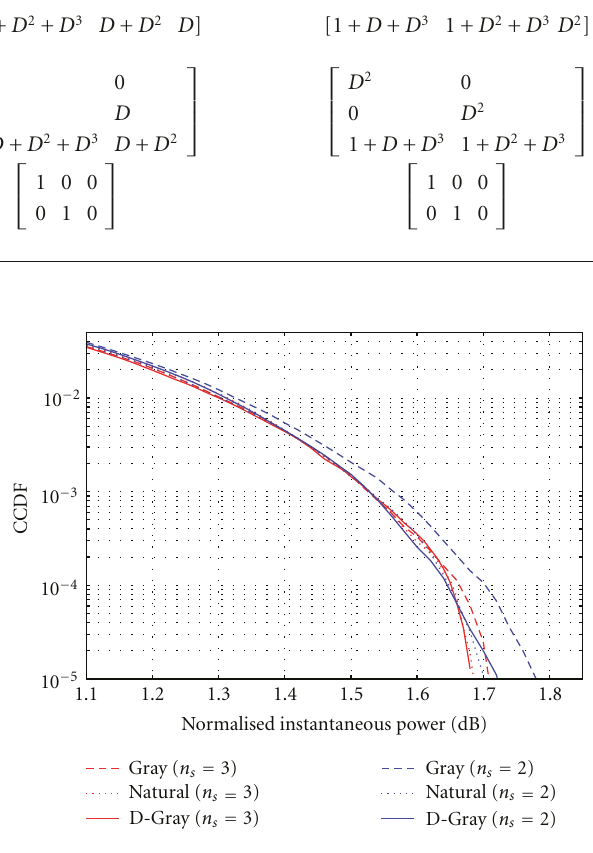
Figure 7: PAPR reduction performance for trellis-shaped 32-PSK with Gray labeling and di ff erent shaping bit allocation (MSB or LSB).